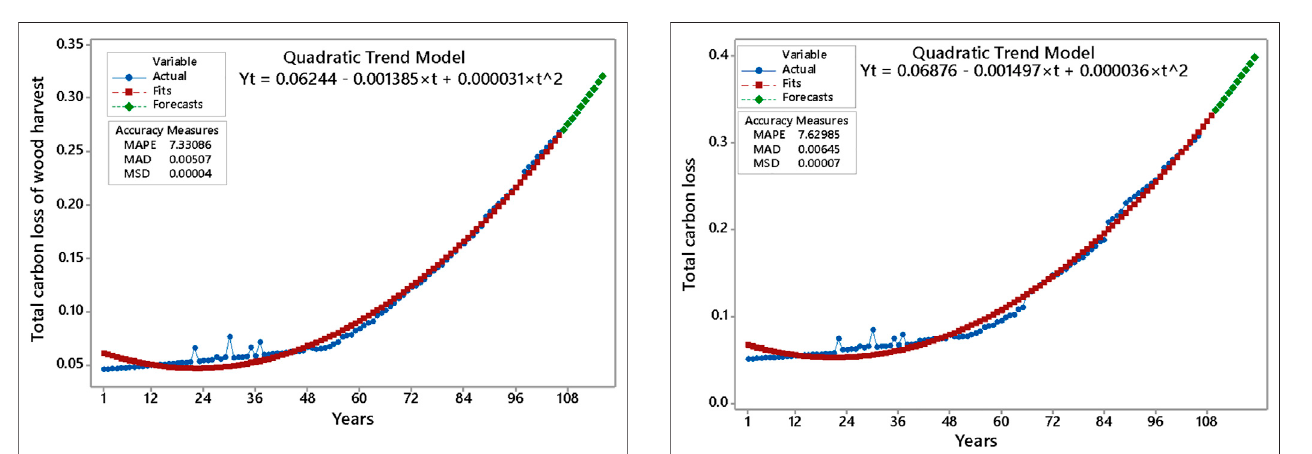
FIGURE 4 | Year-wise trend in carbon loss due to wood harvest (million Mg C). FIGURE 5 | Year wise trend in carbon loss of wood harvest and